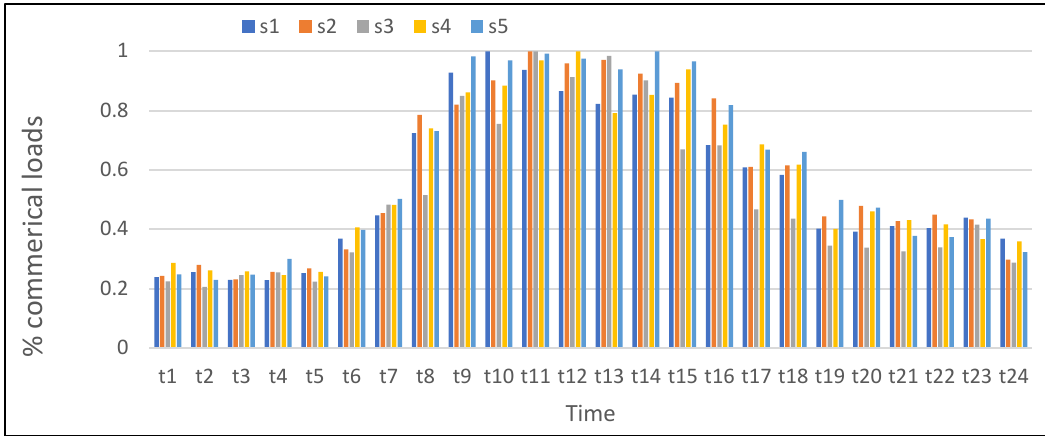
Figure 8. Daily demand profiles for industrial loads. Table 2. Probabilities of different load profiles and DG profiles. Scenario